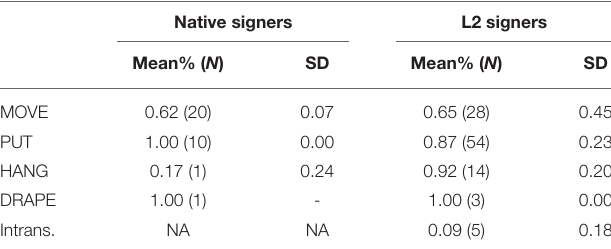
TABLE 3 | Classifier incorporation by verb and group 5